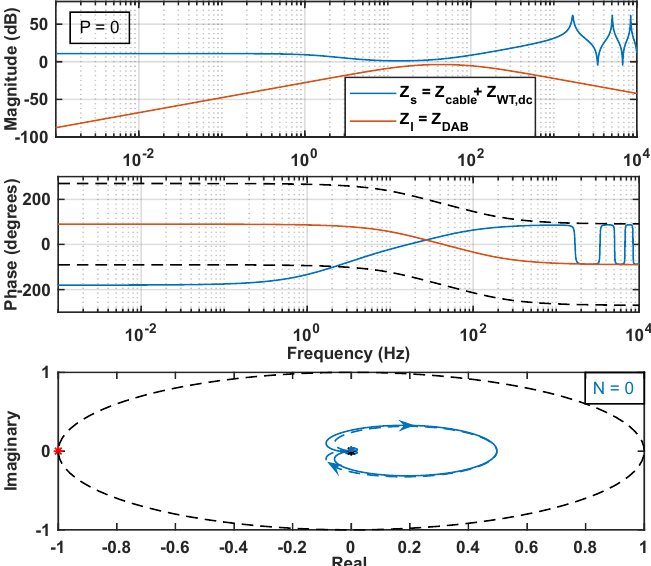
Figure 21. Stability Analysis for Single WT at P 3 .